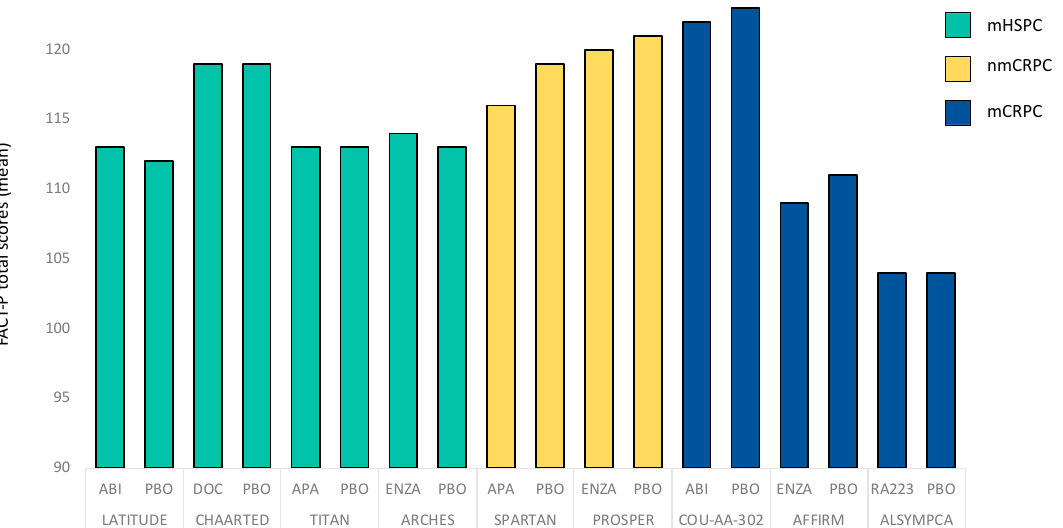
Figure 1. Baseline FACT-P total scores of selected contemporary randomized-controlled trials that focused on metastatic hormone-sensitive prostate cancer (mHSPC), nonmetastatic castration-resistant prostate cancer (nmCRPC) or metastatic castration-resistant prostate cancer (mCRPC). Hereby, higher FACT-P total scores correlate with increased well-being.